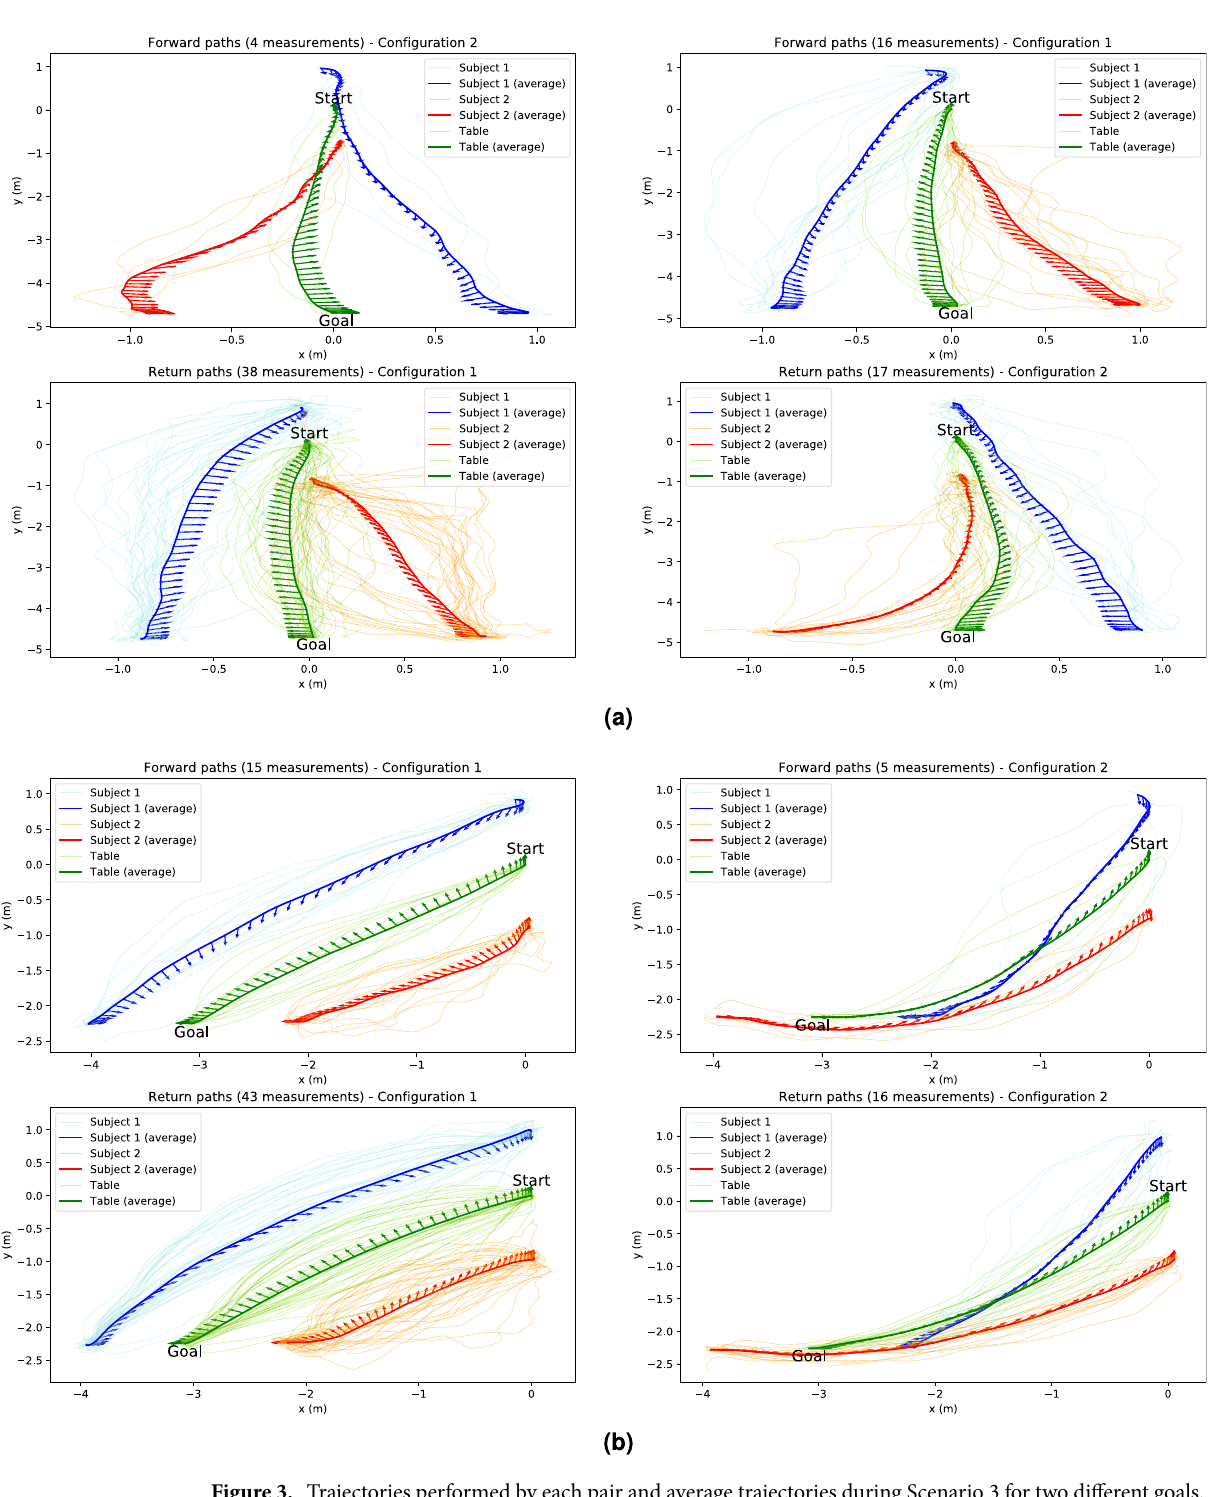
Figure 3. Trajectories performed by each pair and average trajectories during Scenario 3 for two different goals. The trajectories performed for these two goals are typical of the observed straight (Goal 2) and oblique (Goal 6) motions. The arrows represent the average orientation of the pelvis of Subject 1 (in blue) and Subject 2 (in red) and of the table (in green) during locomotion. ( a ) Trajectories toward Goal 2. ( b ) Trajectories toward Goal